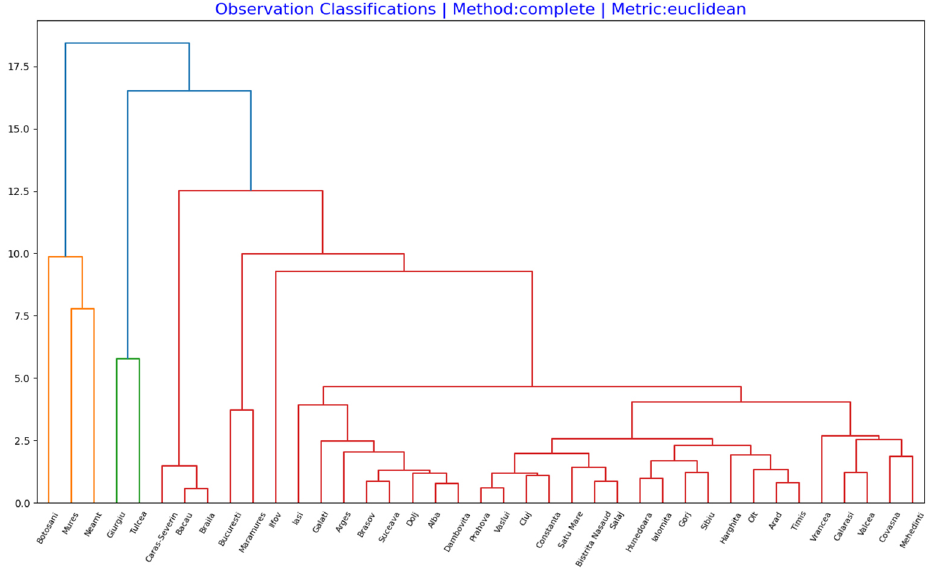
observationsFigure 8. Hierarchical clustering of Romanian counties based on content domain coverage